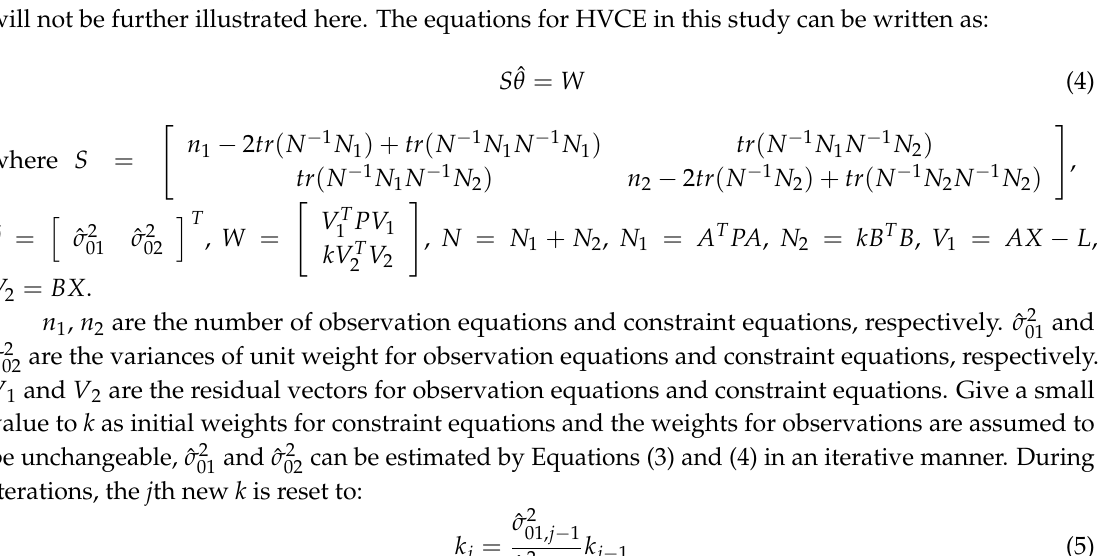
Table 2. Values of k and ˆ σ 2